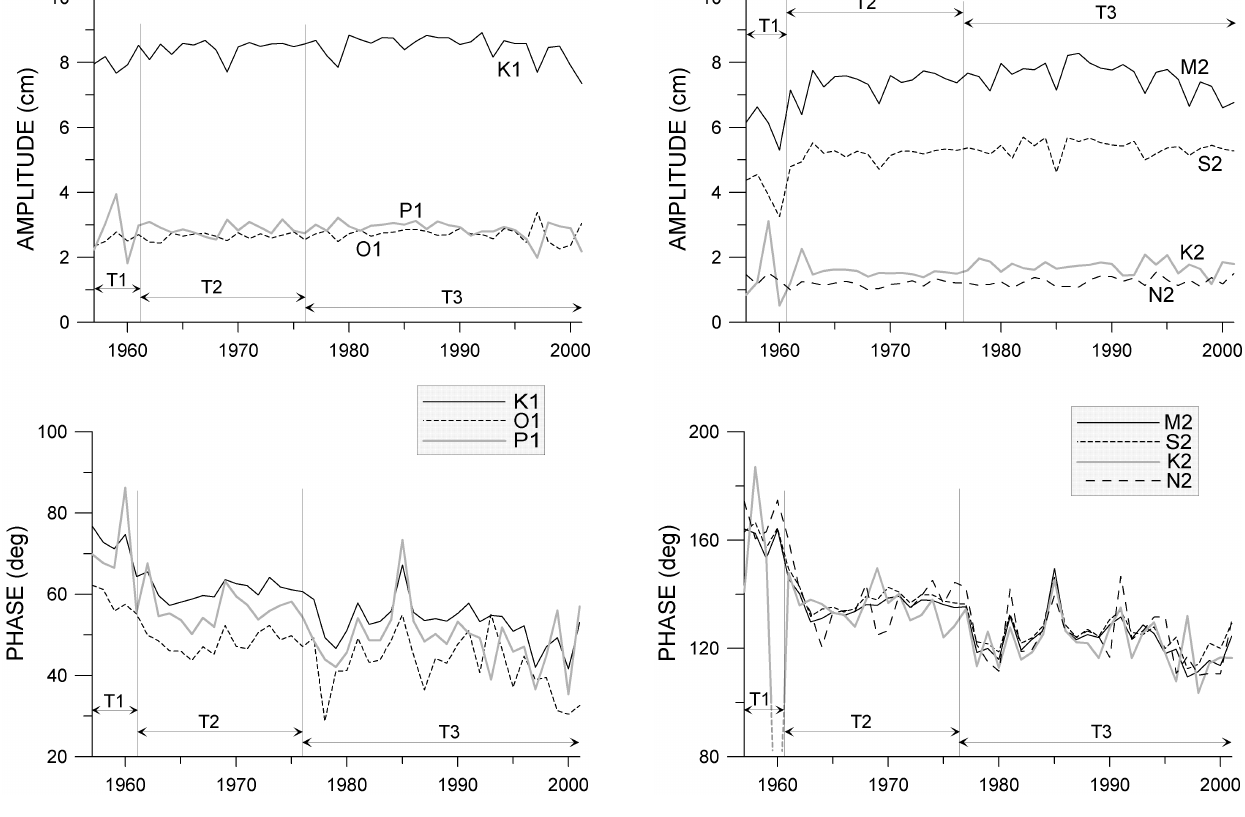
Fig. 2. Annual amplitudes and phases of diurnal constituents calcu- lated for Split in the 1957–2001 period.